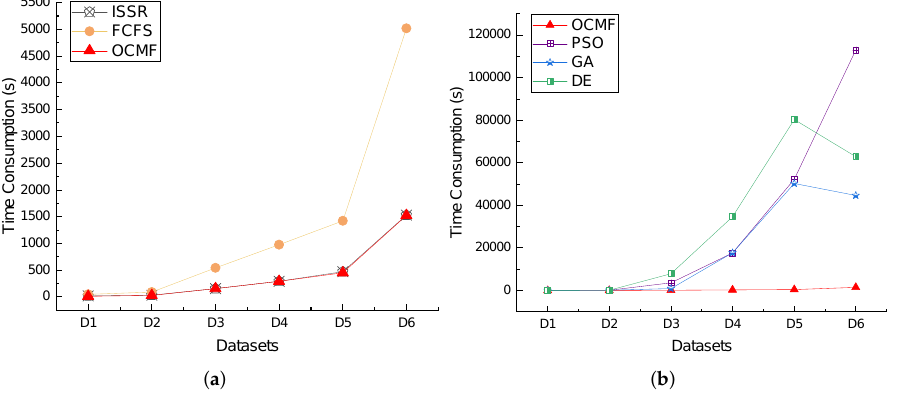
Figure 6. Performance comparison between OCMF and various classic methods. ( a ) Performance comparison between OCMF, ISSR and FCFS approach. ( b ) Performance comparison between OCMF, PSO, GA and DE